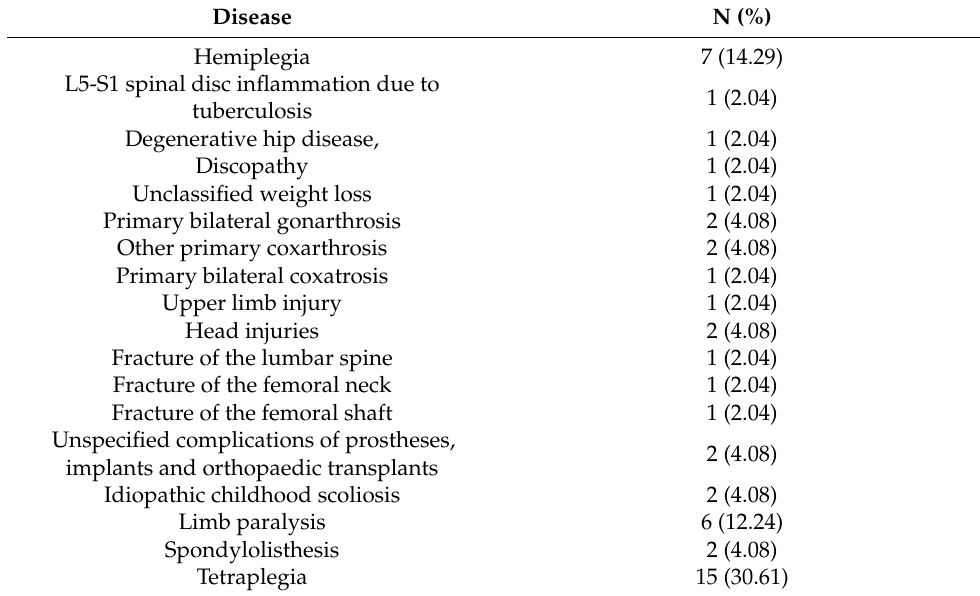
Table 1. Basic diseases and the number of patients diagnosed with nosocomial infections. Disease N